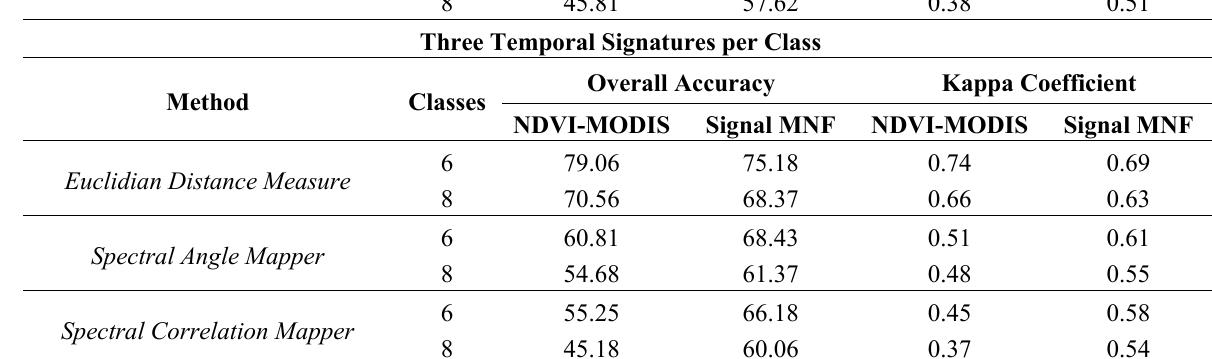
Figure 8 illustrates the classified images using the distance and similarity